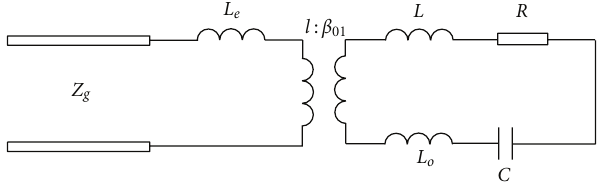
Figure 2: Equivalent circuit of open cavity fed by a rectangular